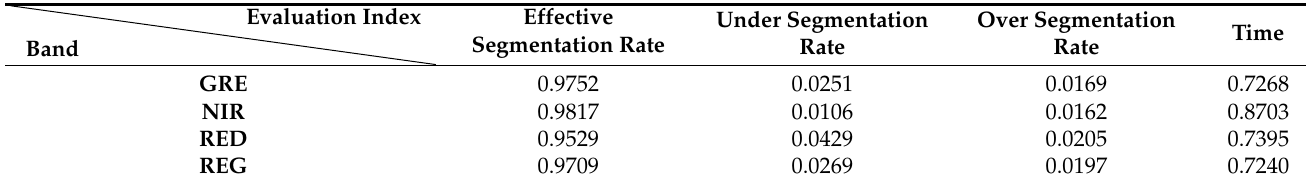
Table 3. Evaluation index results of image